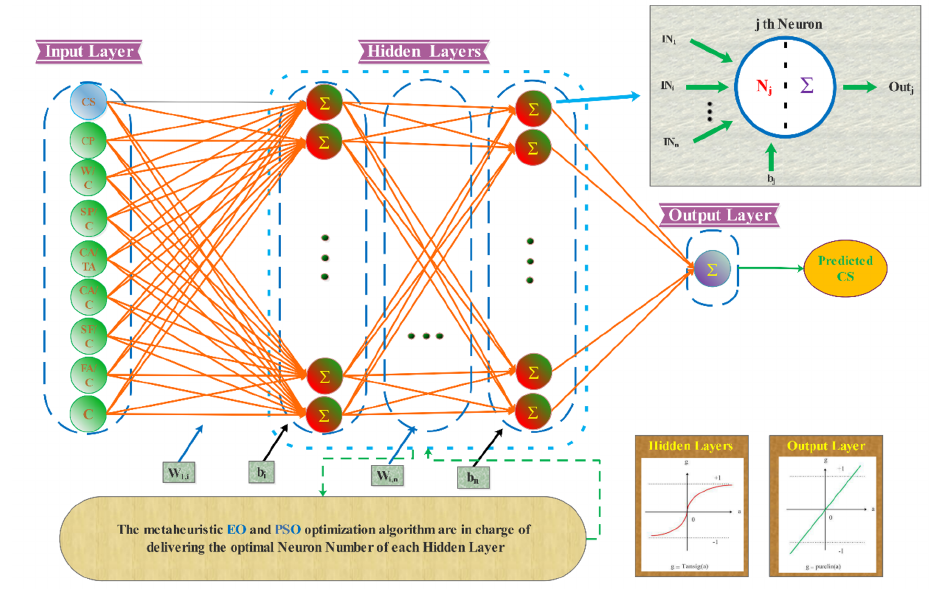
Fig. 4. Flowchart of the developed hybrid neural network and optimized by EO and PSO optimization algorithms Table 2. The results of developed hybrid models based on statistical